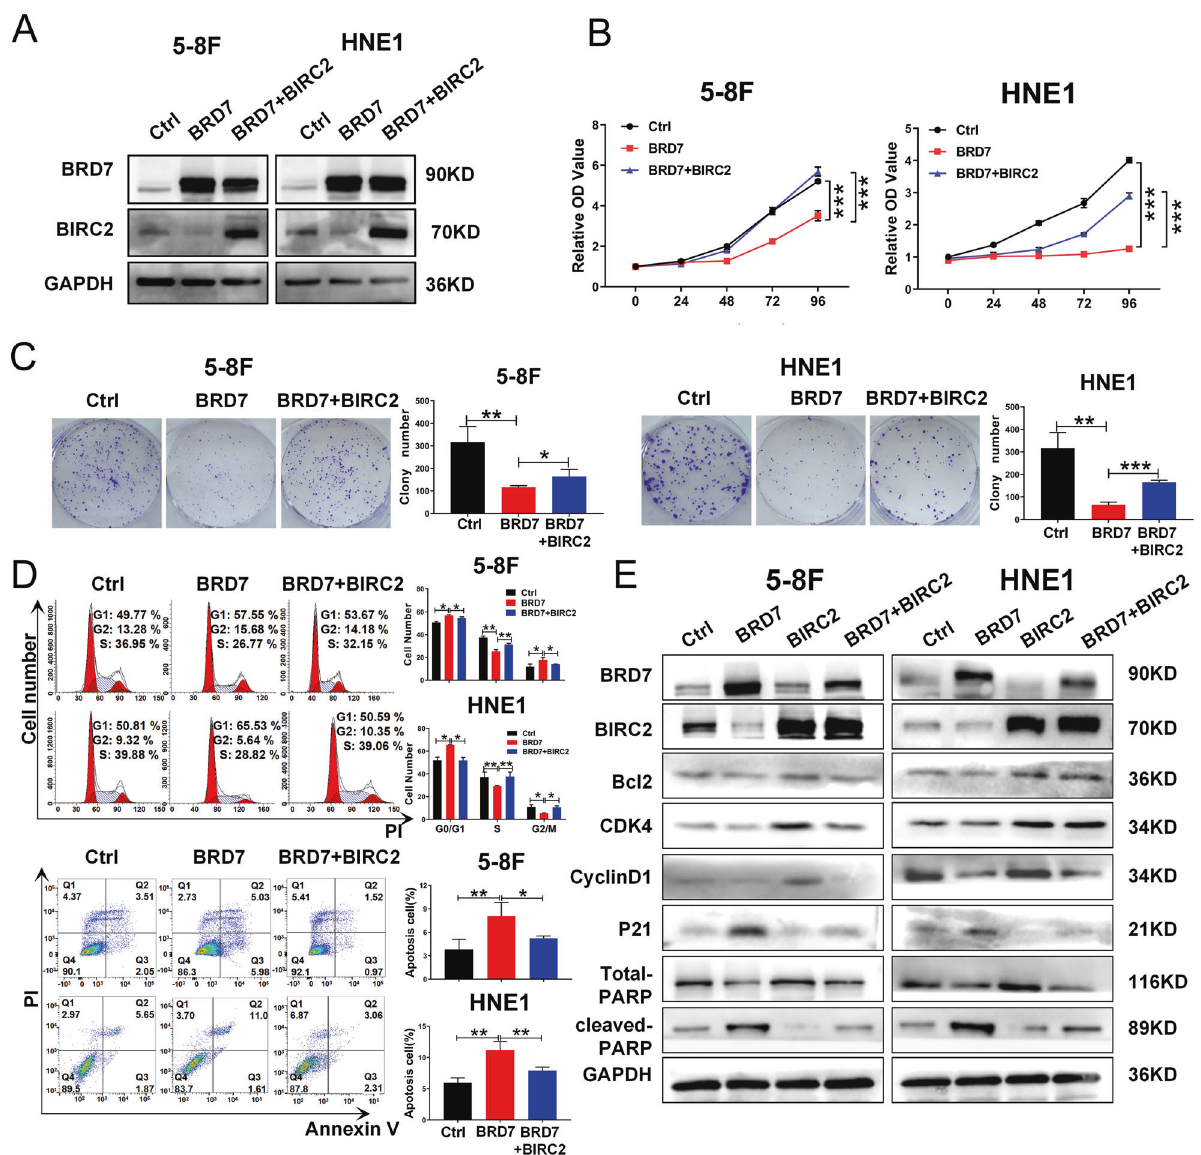
Fig. 4 Restoration of BIRC2 expression reverses the inhibitory effect of BRD7 on cell proliferation. A Western blotting was performed to con fi rm BRD7 and BIRC2 protein levels using antibodies against BRD7 and BIRC2. GAPDH served as an internal control. ( B ) and ( C) CCK-8 analysis and colony-forming assays of cell proliferation in 5-8 F and HNE1 cells stably with BRD7 overexpression, BRD7 and BIRC2 simultaneous overexpression or control group. D Cell-cycle analysis and cell apoptosis by fl ow cytometry. E Signi fi cantly differently expressed proteins involved in cell cycle progression (P21, CCND1 and CDK4) and survival (Total PARP, Cleaved PARP and Bcl2) in BRD7 overexpression, BIRC2 overexpression and BIRC2 restoration cells, respectively. GAPDH served as an internal control. Error bars represent the mean ± SD. *P < 0.05, **P < 0.01, ***P < 0.001; NS, no signi fi cance. All experiments were performed in